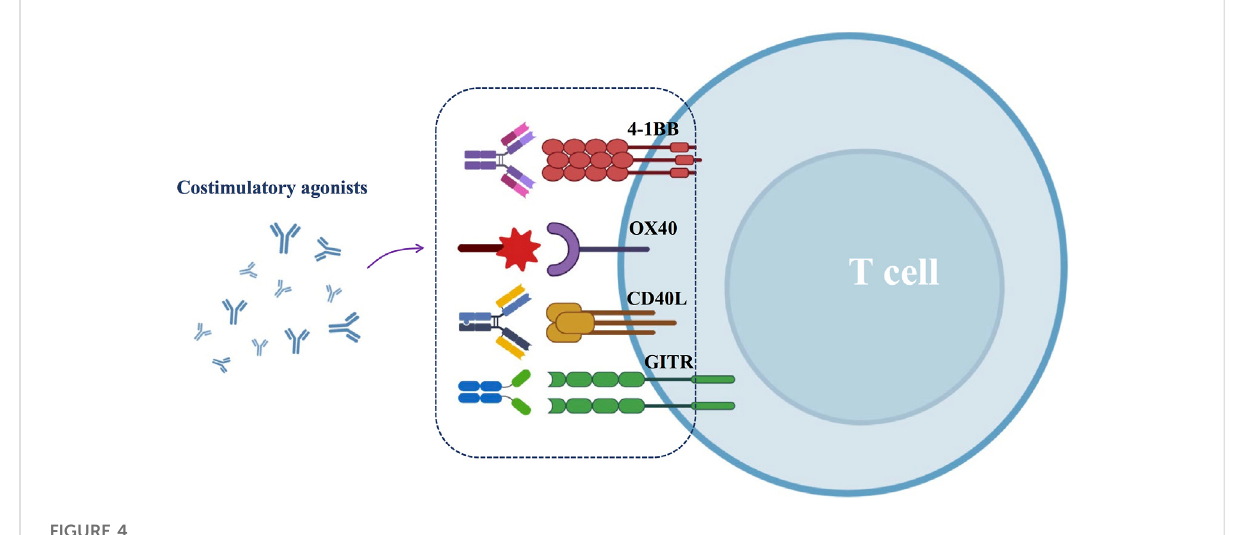
FIGURE 4 Schematic diagram of costimulatory agonists for